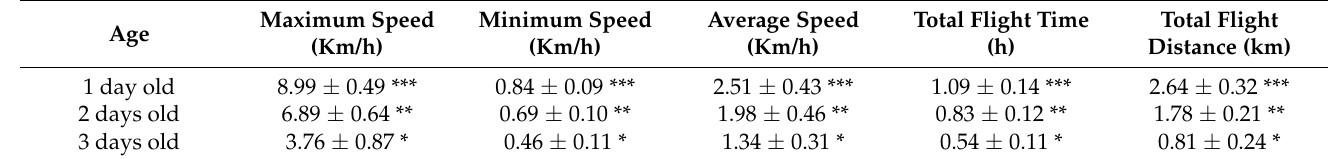
Table 3. Effectiveness of age on female Asian spongy moth ( L. dispar asiatica ) flight speed, time and distance. Values are presented as Mean ± SE.